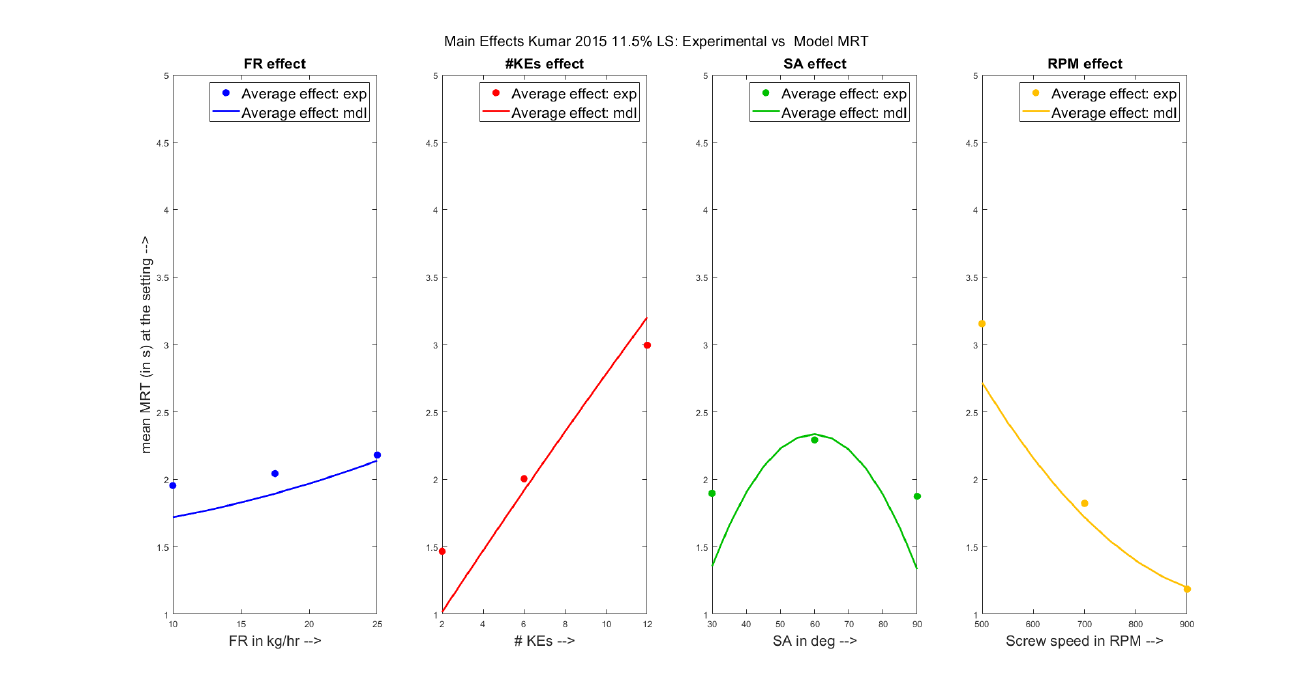
Figure 4. Experimental results vs. Model predictions: Main effects of varied parameters on MRT for the Kumar et al. 2015 [21]